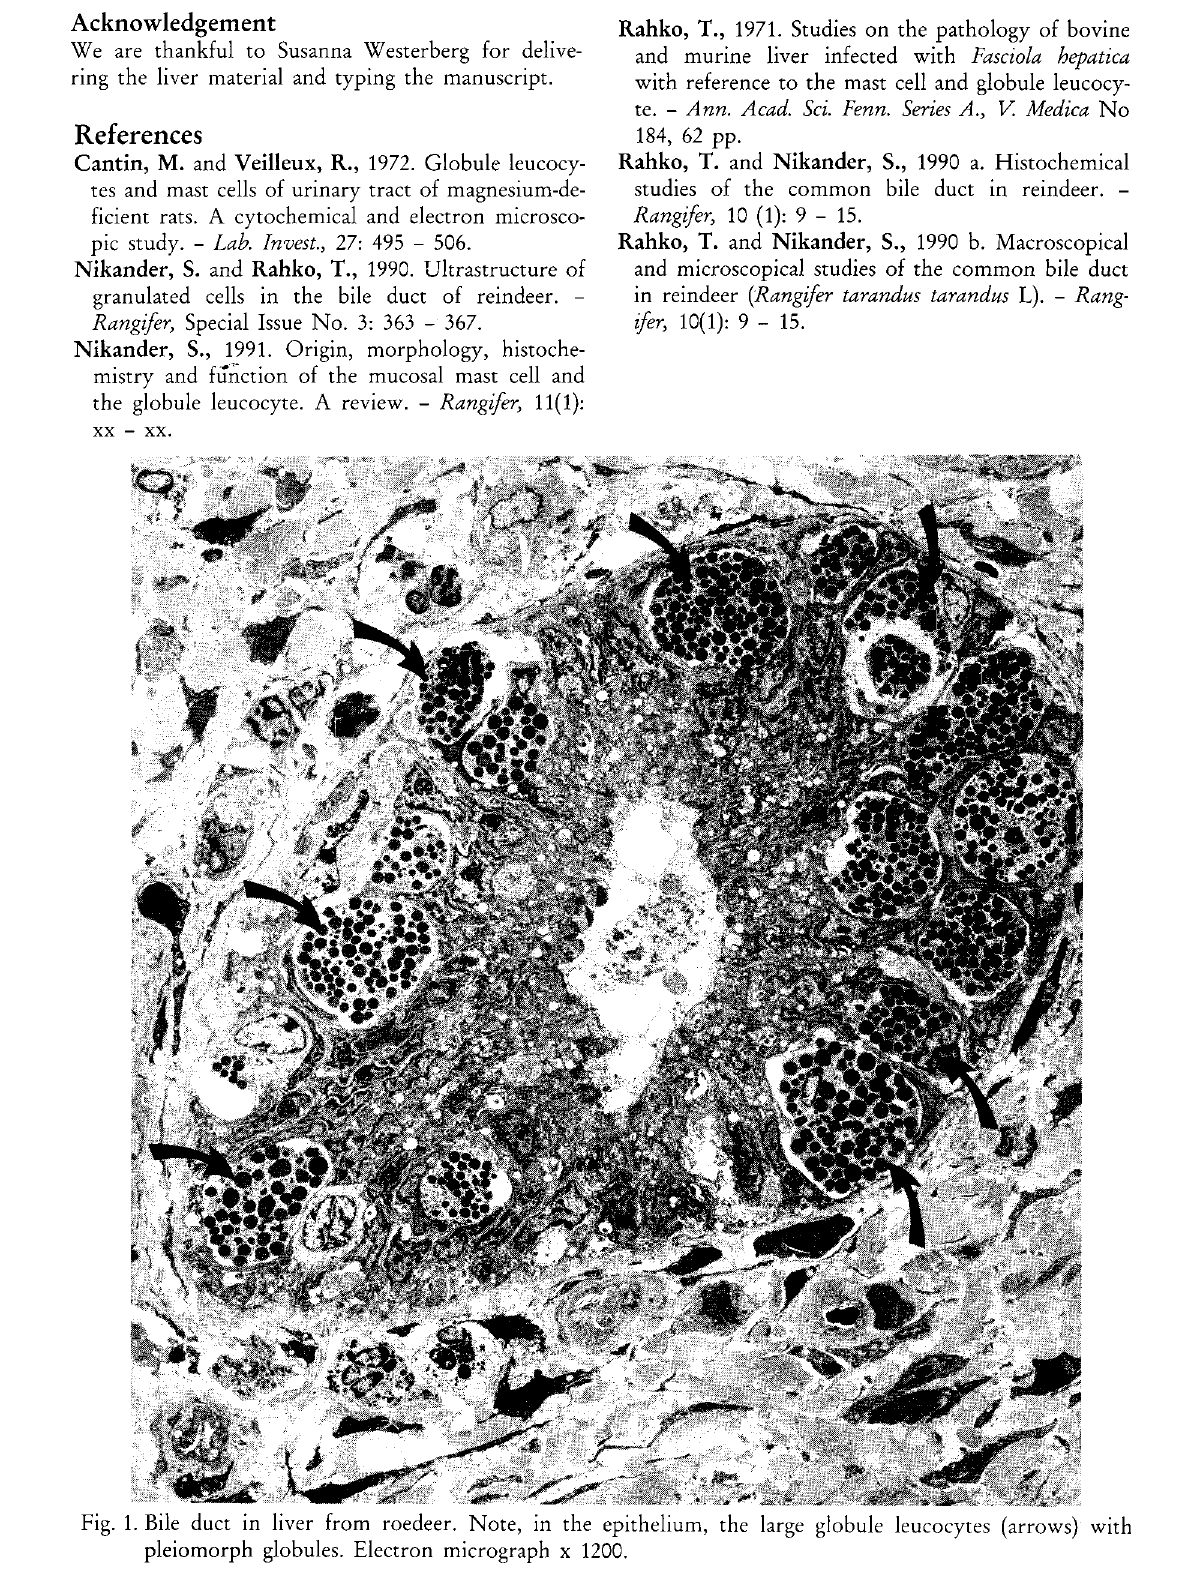
Fig. 1. Bile duct in liver from roedeer. Note, in the epithelium, the large globule leucocytes (arrows) with pleiomorph globules. Electron micrograph x